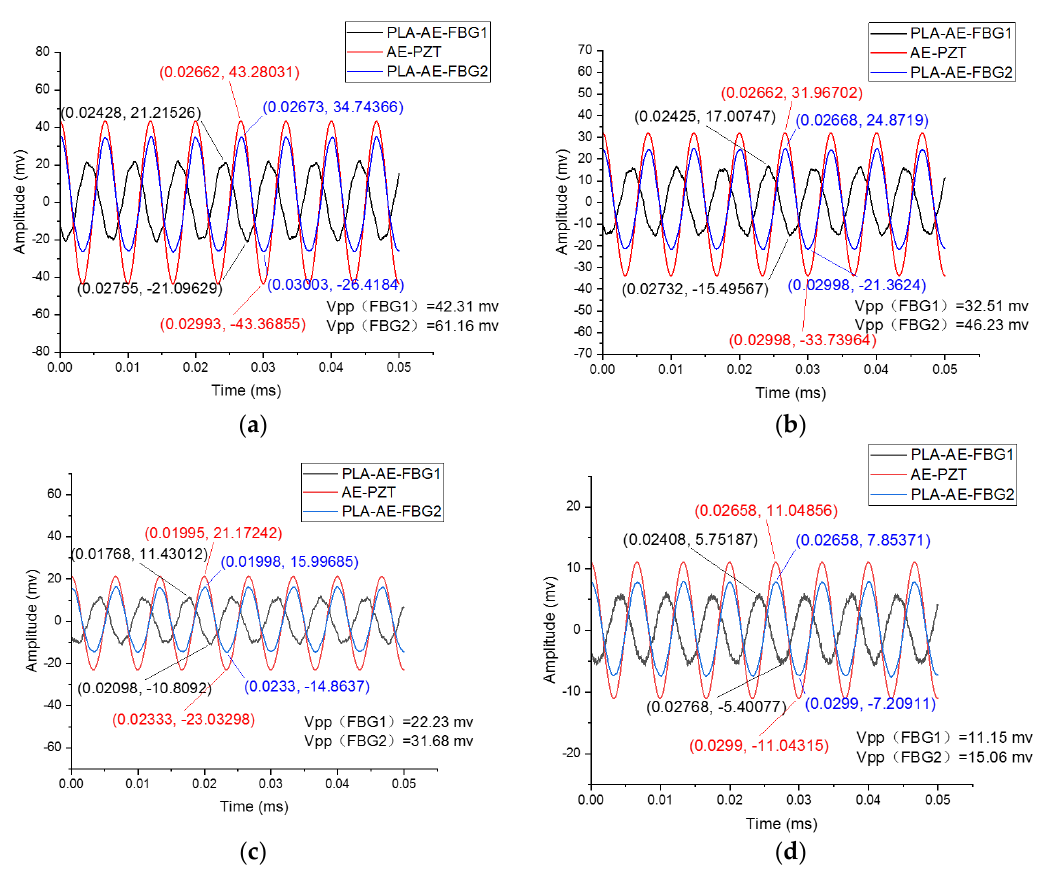
Figure 17. The comparison of the FBG AE sensor and the PZT AE sensor under different amplitude excitations ( a ) The peak-peak value of the excitation signal is Vpp = 20 V; ( b ) The peak-peak value of the excitation signal is Vpp = 15 V; ( c ) The peak-tpeak value of the excitation signal is Vpp = 10 V; ( d ) The peak-peak value of the excitation signal Vpp = 5 V.